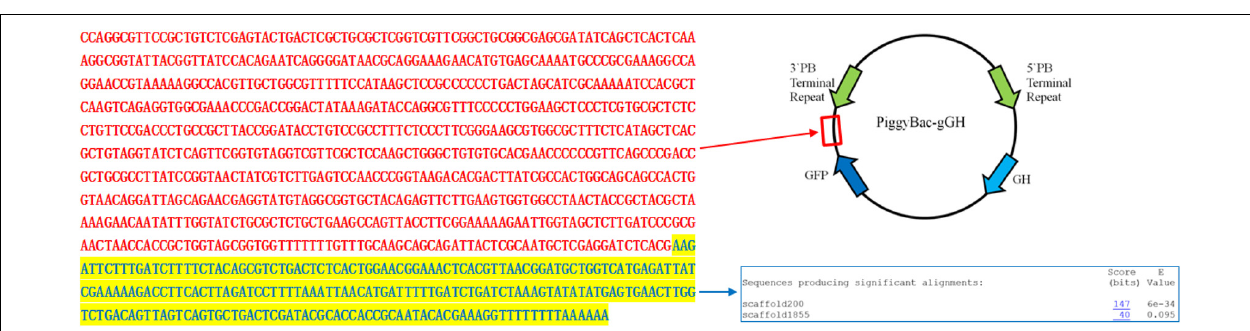
FIGURE 6 | Sequence obtained by genome walking using genomic DNA from transgenic oyster larvae as template. The sequence in red corresponds to partial vector sequence downstream of the GFP gene in piggyBac-gGH , and sequence in blue aligns with the scaffold200 in Pacific oyster genome